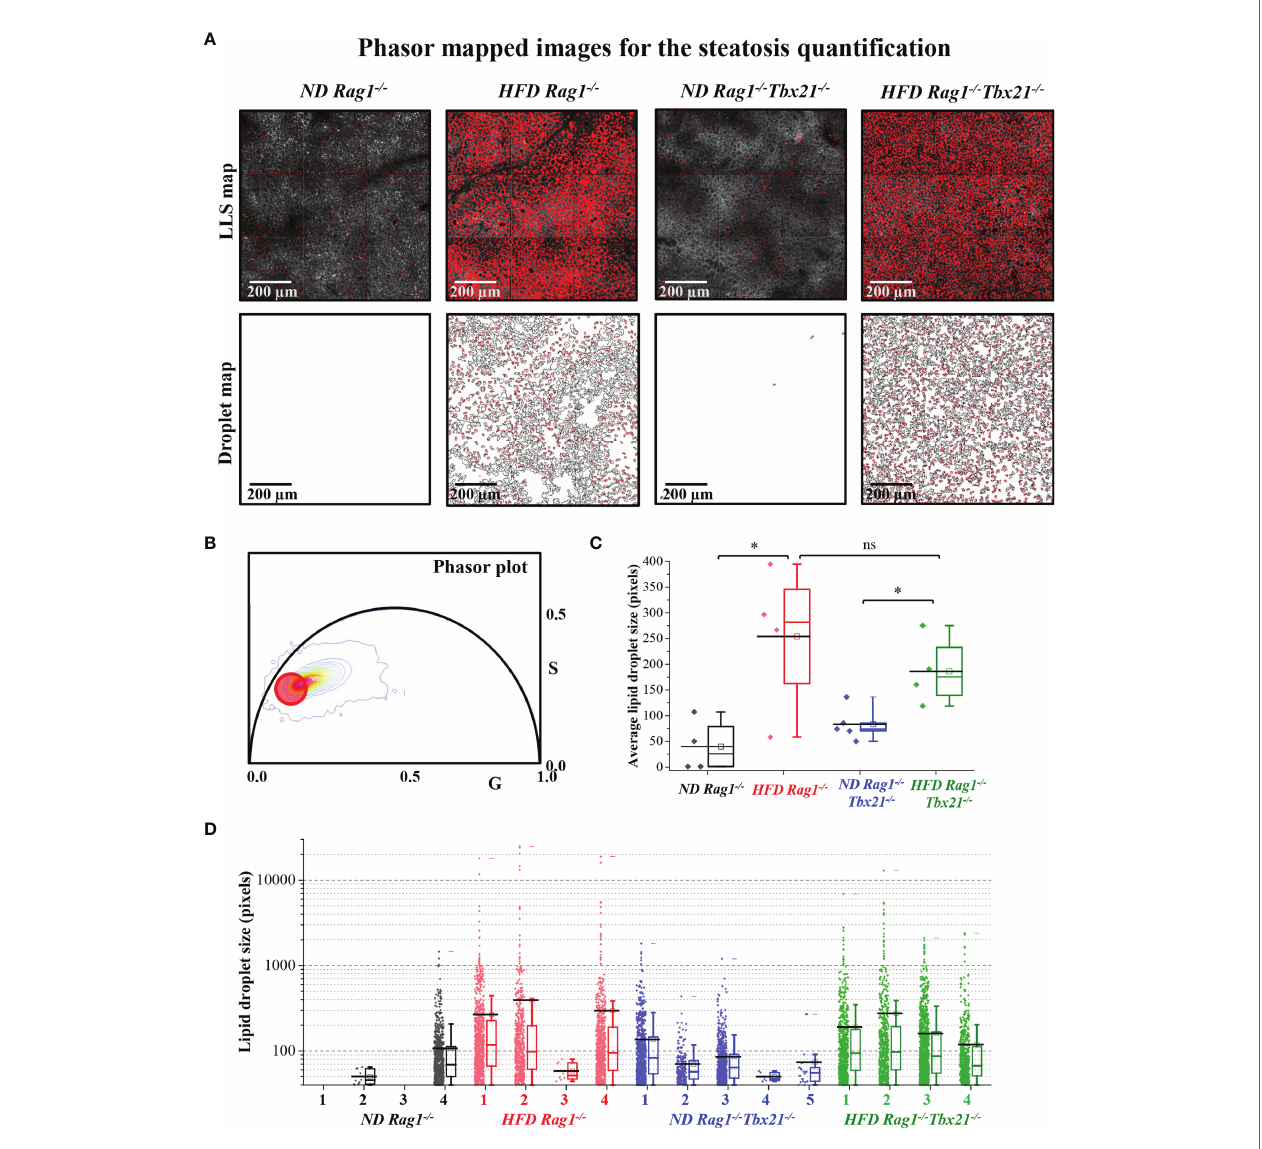
FIGURE 2 | Steatosis quanti fi cation using long lifetime species of phasor-in Rag1 -/- and Rag1-Tbet DKO hepatic IRI mouse model. HFD was started at fi ve-to-seven weeks of age and maintained for 12 weeks. All mice were 17-19 weeks at time of evaluation. (A) Fluorescence lifetime images were color mapped for long lifetime species (LLS) present in lipid droplets, and their size distribution was calculated using a custom ImageJ script (droplet map is shown in Figure 2A , bottom). (B) The LLS signal was selected based on the phasor-FLIM map (red circle). The calculated average lipid droplet sizes (C) and the individual droplet size distributions are plotted (D) . The excitation wavelengths used were 740 nm. Signi fi cance was determined using Mann Whitney Test. *p<0.05; ns, not signi fi cant. Each dot represents the value for a single